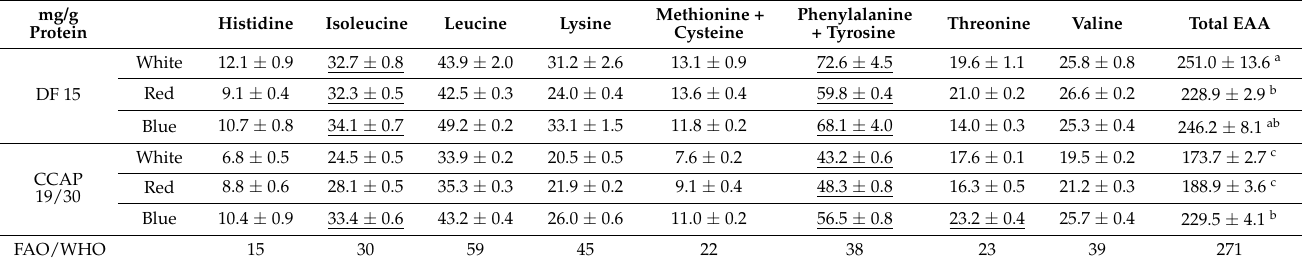
Table 1. Individual and total amino acid contents of D. salina DF15 and D. salina CCAP19/30 at the end of the experiment with the FAO/WHO reference.